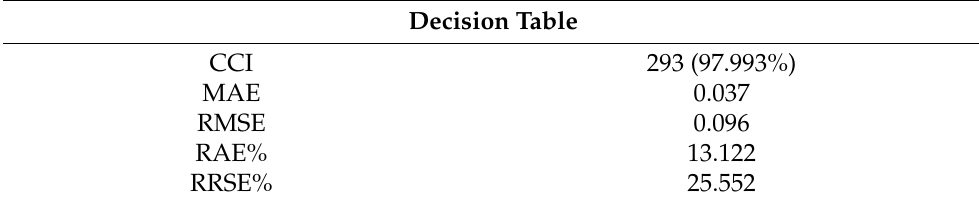
Table 13. CCI and Error Rates details achieved via